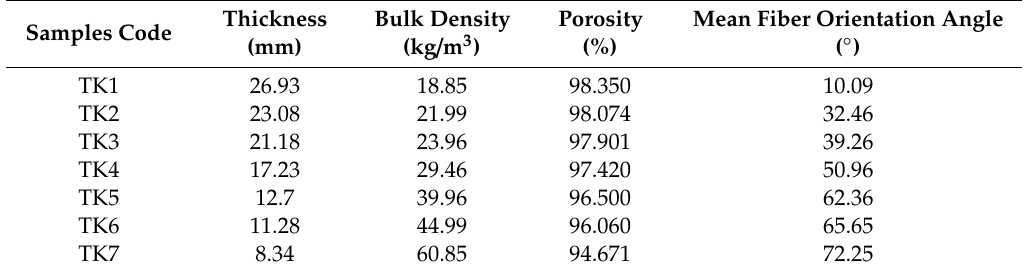
Table 3. Basic characteristics of the polyester nonwoven fibrous samples.